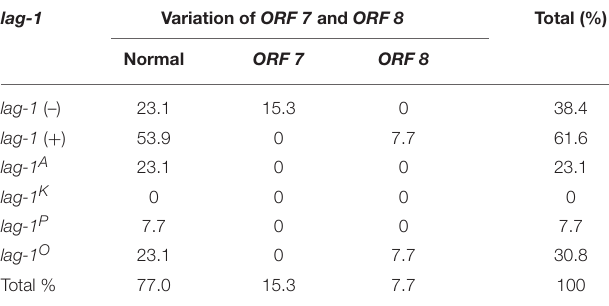
TABLE 3 | Chinese clinical isolates (n = 13) were divided into 15 subgroups of sg1.